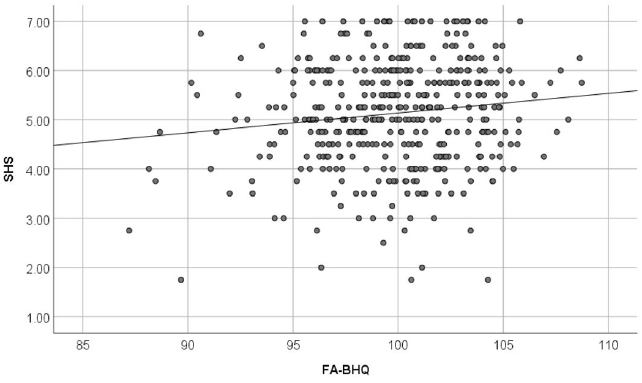
Figure 6. Scatter plot showing the relationship between FA-BHQ and